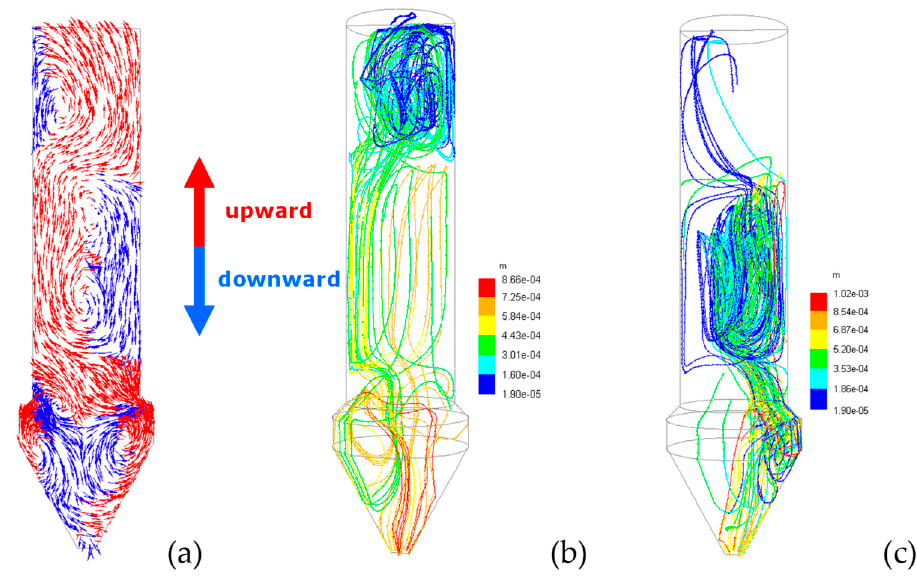
Figure 15. Comparison of drying air flow ( a ) and particle trajectories for upper ( b ) and lower ( c ) nozzles level, Ref. [38].